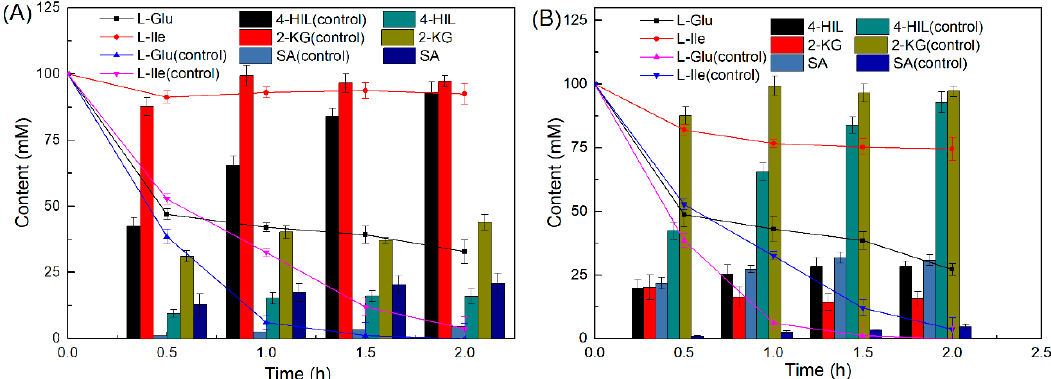
Figure 4. One-pot cascade reaction to produce 4-HIL. ( A ) One-pot cascade reaction in the absence of Fe 2+ ; ( B ) one-pot cascade reaction in the presence of Fe 2+ .